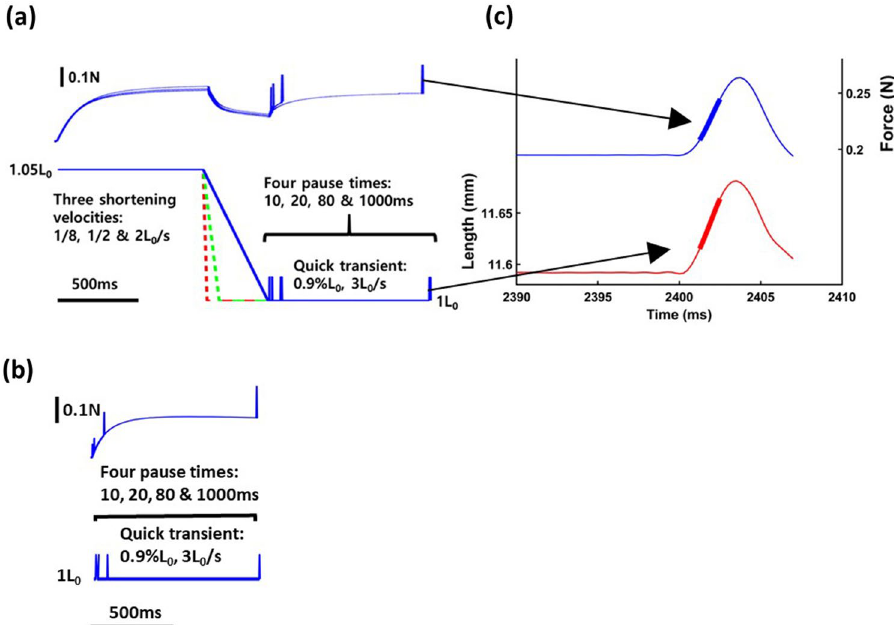
Figure 6. Muscle force ( a , upper trace) and length ( a , lower trace) in the active shortening group, muscle force ( b , upper trace) and length ( b , lower trace) in the pure isometric group and measurement of instantaneous muscle stiffness ( c ). ( a ) Protocols used to evaluate the effects of active shortening and duration of isometric force redevelopment on muscle stiffness and force. Active shortening was performed from 1.05L 0 to L 0 at three different velocities; 1/8 L 0 /s (red), ½ L 0 /s (green) and 2 L 0 /s (blue). Instantaneous muscle stiffness was measured using a quick transient with an amplitude of 0.9% L 0 and a velocity of 3L 0 /s for four pause durations (10, 20, 80 and 1000 ms). ( b ) Pure isometric contraction was performed at L 0 . Instantaneous muscle stiffness was measured using a quick transient for four pause duration (10, 20, 80 and 1000 ms). ( c ) Muscle force (upper trace, blue) responded to a rapid transient (lower trace, red) at 3L 0 /s. The linear parts of the force–time trace (thick line, blue) and the length–time trace (thick line, red) were used to determine stiffness. The linear slope of the force– time trace was divided by the linear slope of the length–time trace, which gives the stiffness of muscle (N/mm) at steady